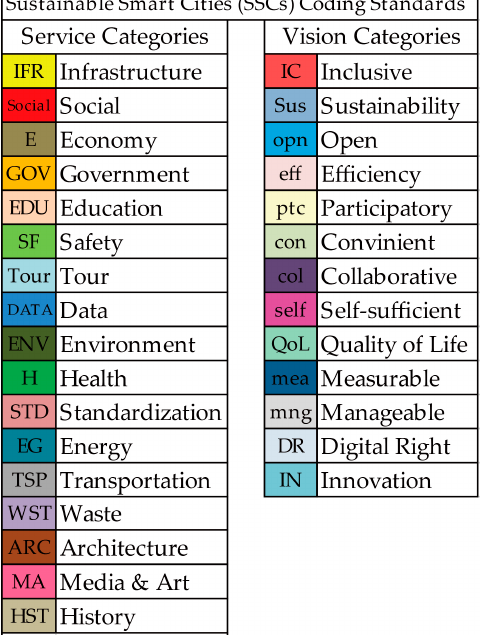
Figure 4. The Sustainable Smart Cities Coding Standards.